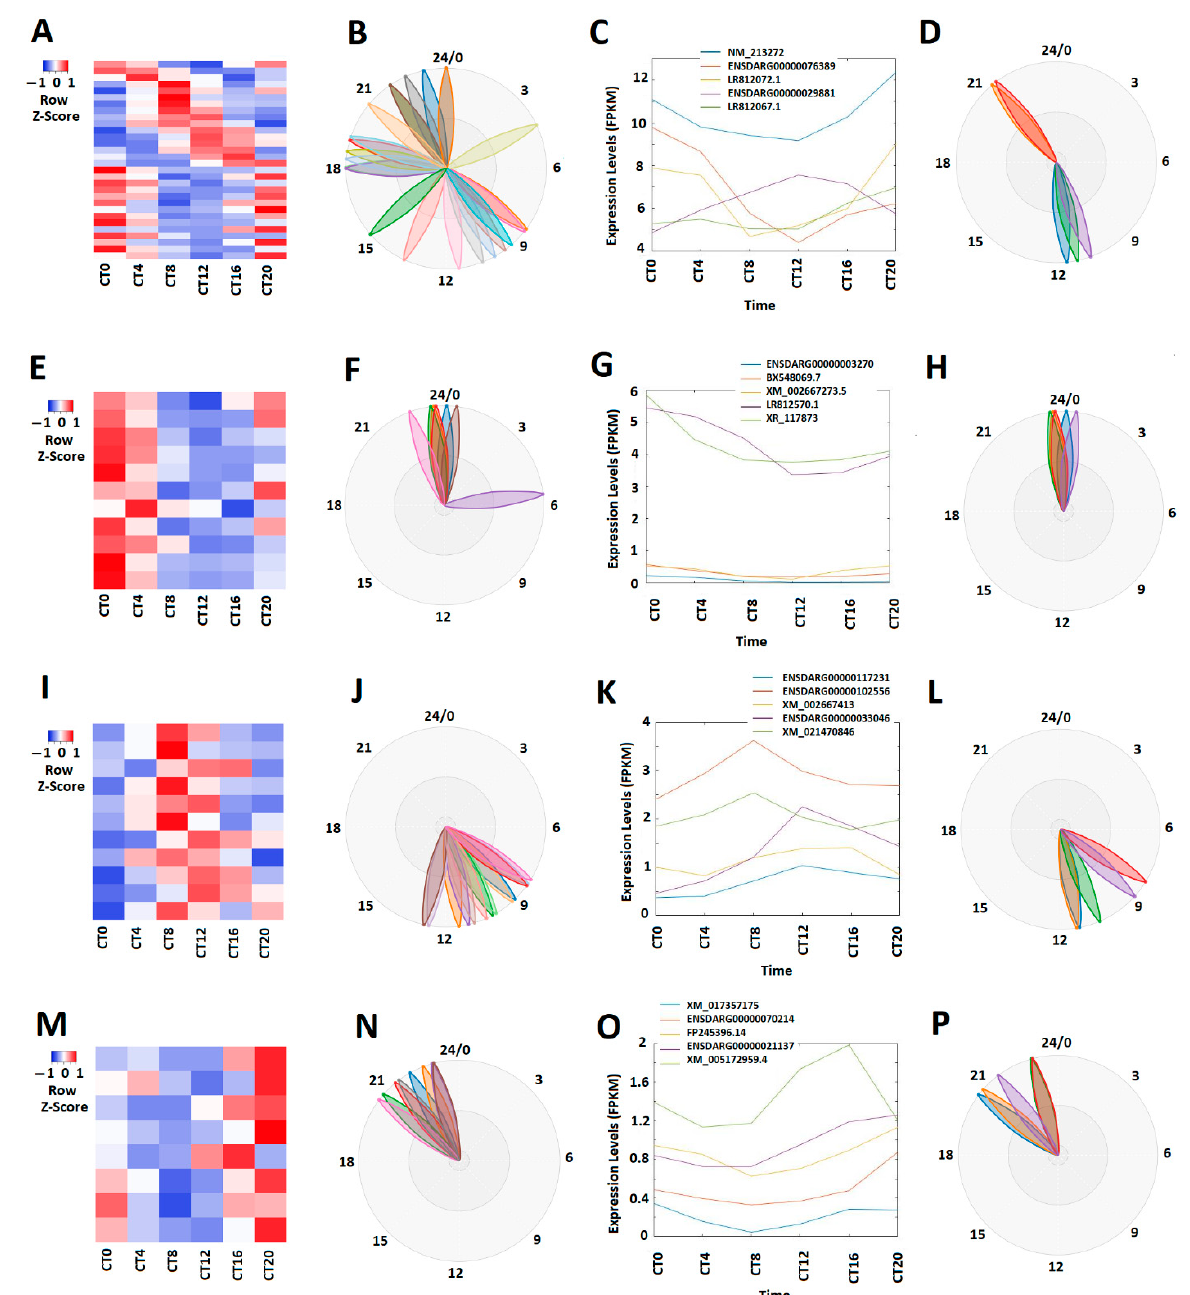
Figure 5. Expression profile analysis of circadianly expressed zebrafish larval lncRNAs coexpressed under both the DD condition and the LL condition. ( A – D ) Analysis of all the 30 coexpressing larval lncRNAs with expression profiles from DD condition. Heat map ( A ) and BioDare2 plots ( B ) of all the 30 coexpressing larval lncRNAs, expression profiles ( C ) and BioDare2 plots ( D ) of representative lncRNAs. ( E – H ) Analysis of the 11 coexpressing larval morning (CT0 and CT4) lncRNAs. Heat map ( E ) and BioDare2 plots ( F ) of the 11 larval morning lncRNAs, expression profiles ( G ) and BioDare2 plots ( H ) of larval morning representative lncRNAs. ( I – L ) Analysis of the eight coexpressing larval evening (CT8 and CT12) lncRNAs. Heat map ( I ) and BioDare2 plots ( J ) of eight larval evening lncRNAs, expression profiles ( K ) and BioDare2 plots ( L ) of larval evening representative lncRNAs. ( M – P ) Analysis of eight coexpressing larval night (CT16 and CT20) lncRNAs. Heat map ( M ) and BioDare2 plots ( N ) of eight larval night lncRNAs, expression profiles ( O ) and BioDare2 plots ( P ) of larval night representative lncRNAs.